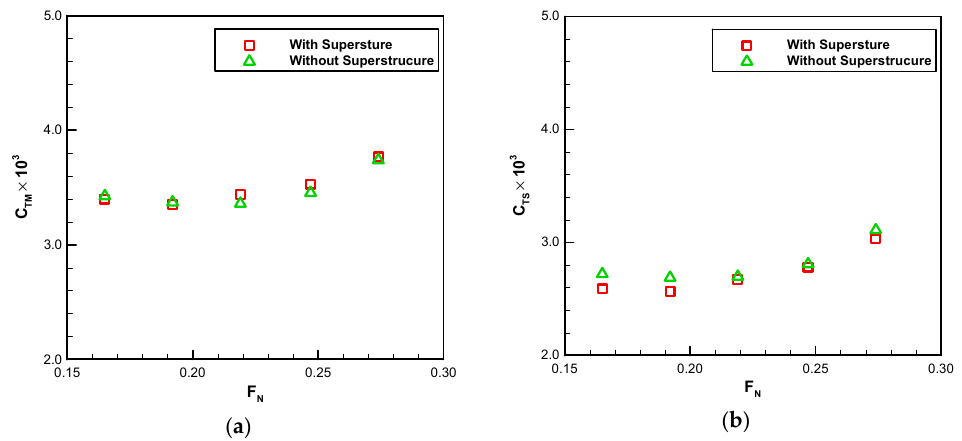
Figure 9. Comparison of total resistance coefficient for ships, with and without a superstructure. ( a ) Model scale and ( b ) full scale.